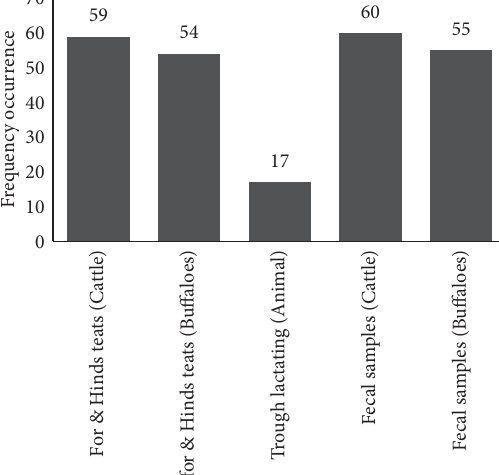
Shigella spp . 44 (29%) Salmonella spp .